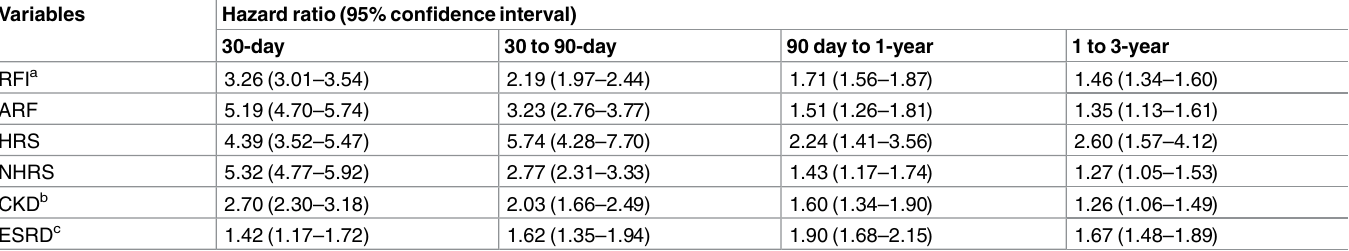
Table 3. Adjustedhazard ratiosof different typesof renal functionimpairment for the 30-day, 30 to 90-day, 90-day to 1-year, and 1 to 3-year mortal- ity of cirrhotic patients,comparedwithnon-renalfunction impairment group. Variables